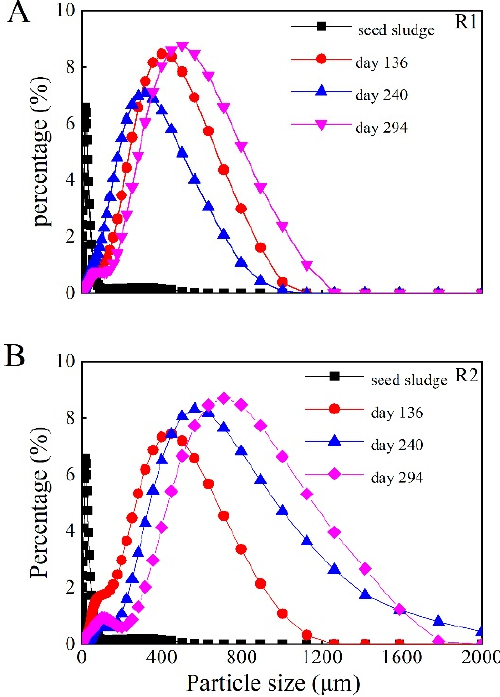
Figure 3. Size distribution and development of aerobic granules in R1 and R2 over the operating time. ( A ) R1; ( B ) R2.